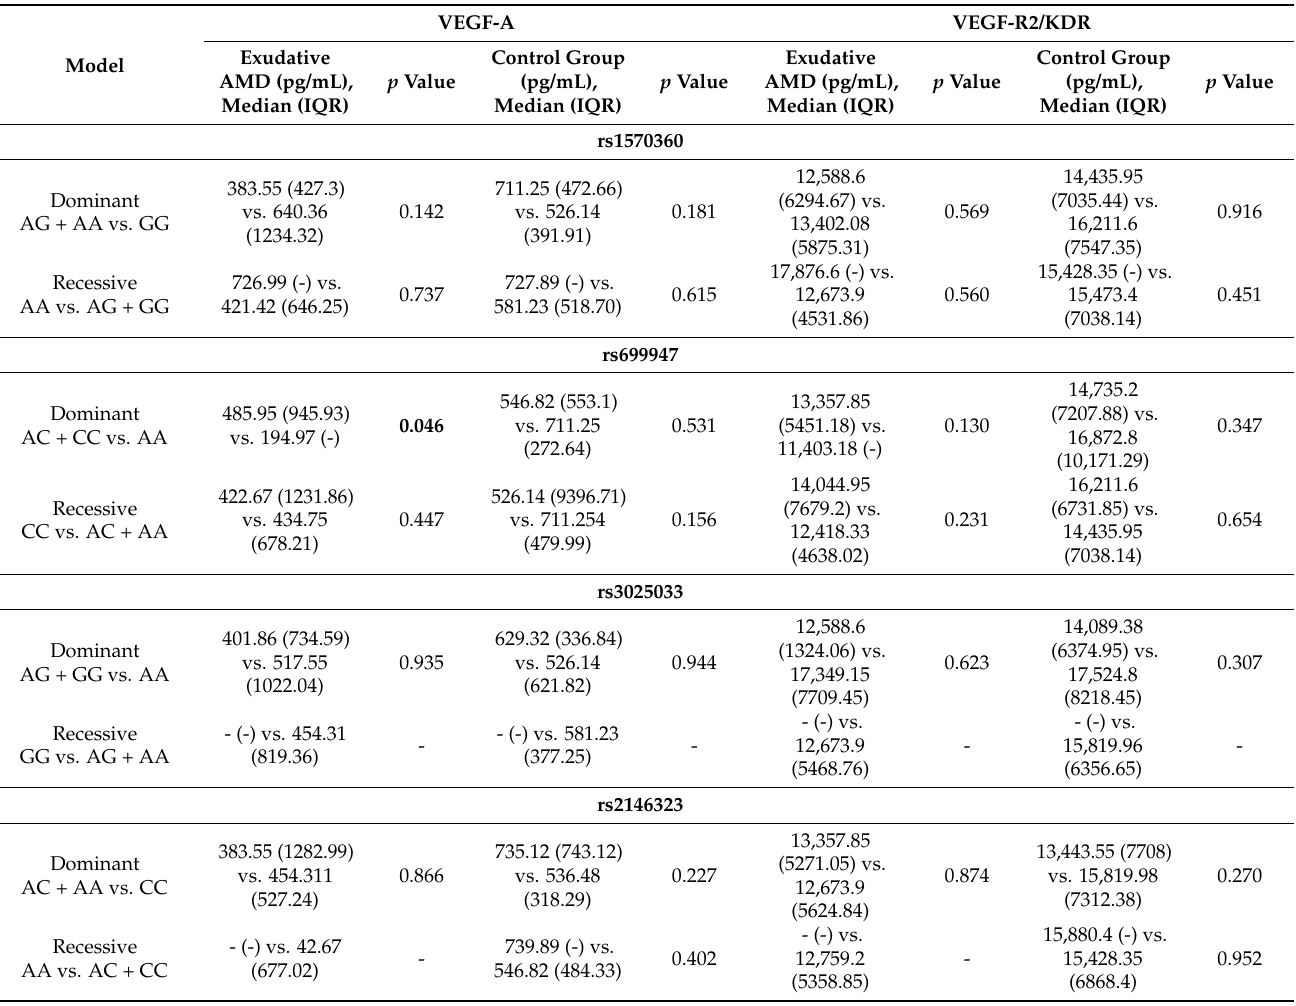
Figure 3. VEGF-R2/KDR serum concentrations between groups. The bars represent the median with interquartile range (first quartile and third quartile) and whiskers from minimum to maximum. VEGF-R2/KDR serum concentration in exudative AMD group: (12,759.2 (5358.85) pg/mL and control group: 15,428.35 (6698.03) pg/mL. Mann–Whitney-U test, p = 0.183. 3.5. VEGF-A and VEGF-R2/KDR Concentrations by VEGFA Genotypes We also performed VEGF-A and VEGF-R2/KDR serum concentration and VEGFA rs1570360, rs699947, rs302503, and rs2146323 genotype association analysis and found that patients with exudative AMD carrying at least one C allele at rs699947 have statistically significantly higher VEGF-A serum concentrations compared to wild-type allele A homozy- gous genotypes carriers (485.95 (945.93) vs. 194.97 (-), respectively, p = 0.046) (Table 7). However, there were only two subjects with the AA genotype. Table 7. VEGF-A and VEGF-R2/KDR concentration associations with VEGFA polymorphisms in exudative AMD and